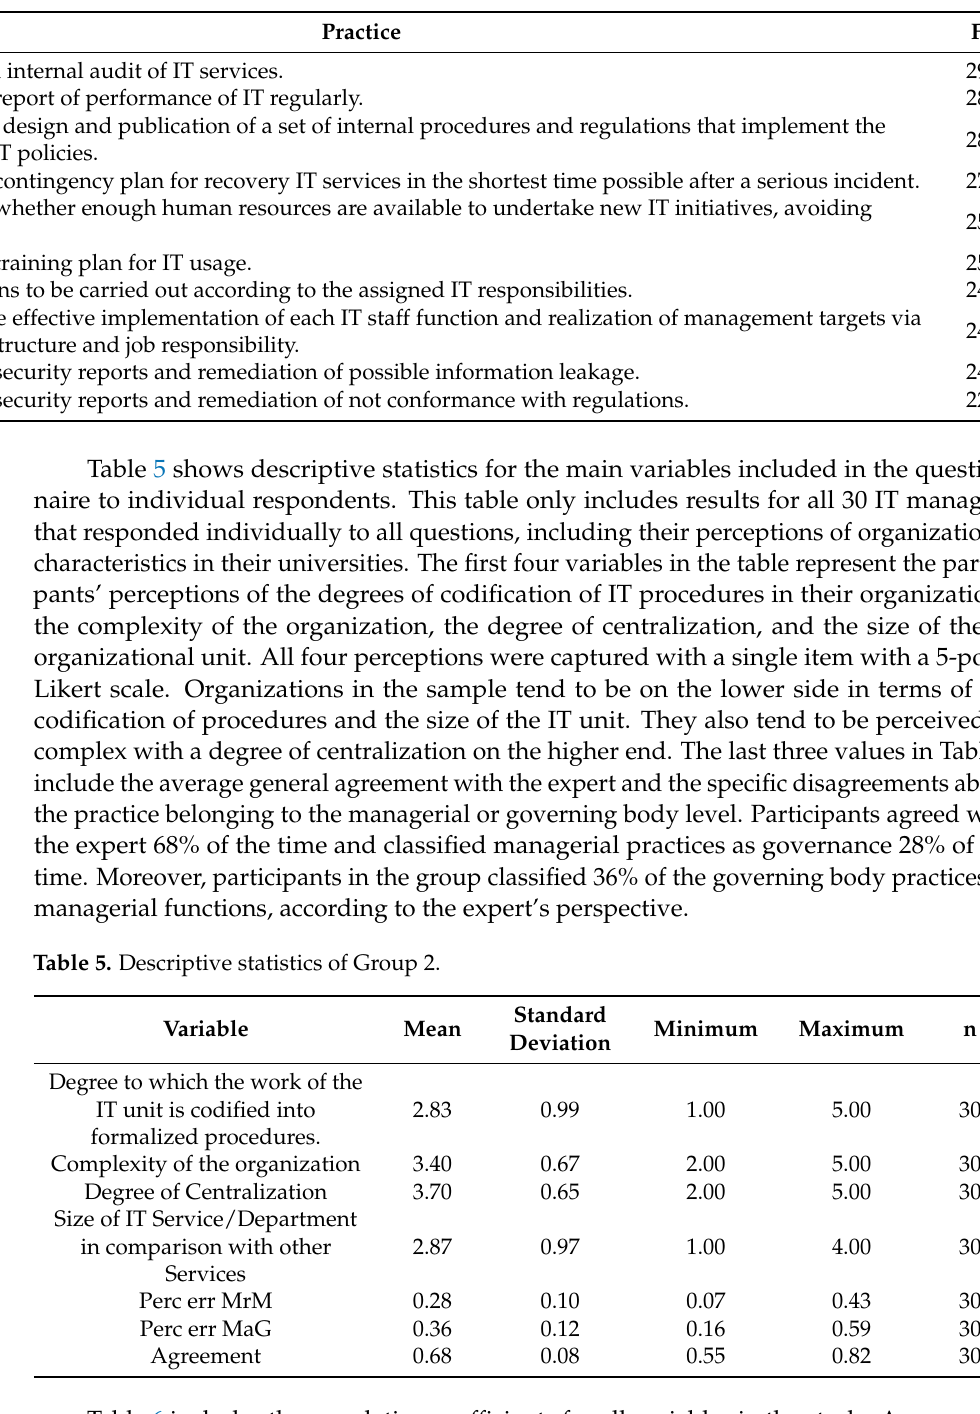
Table 4. List of best practices with higher frequency of MaG divergence (classifying them as manage- ment governance practices).